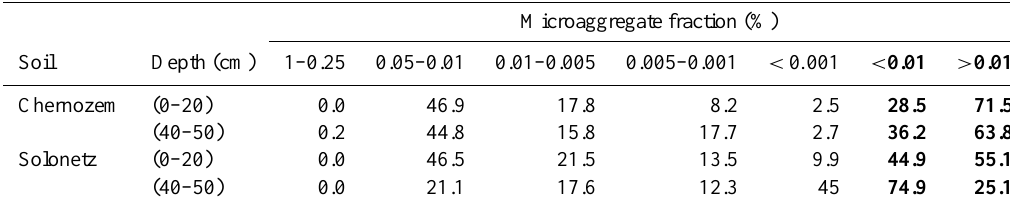
Table 2. The microaggrgate composition of the Chernozem and Solonetz soils at different depths.